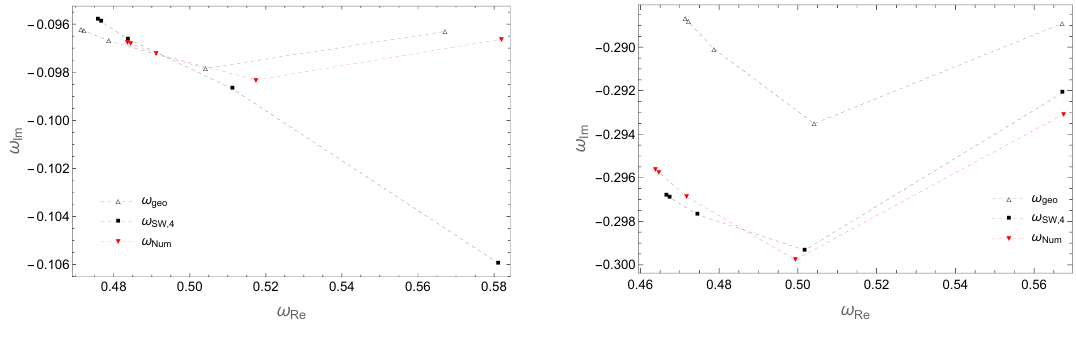
Figure 2 . QNMs of a RN BH for n Num = 1 (left) and n Num = 2 (right), ‘ = m φ = 2 , with a = 0 , M = 1 . Q varies between 0 and 0 . 9 .